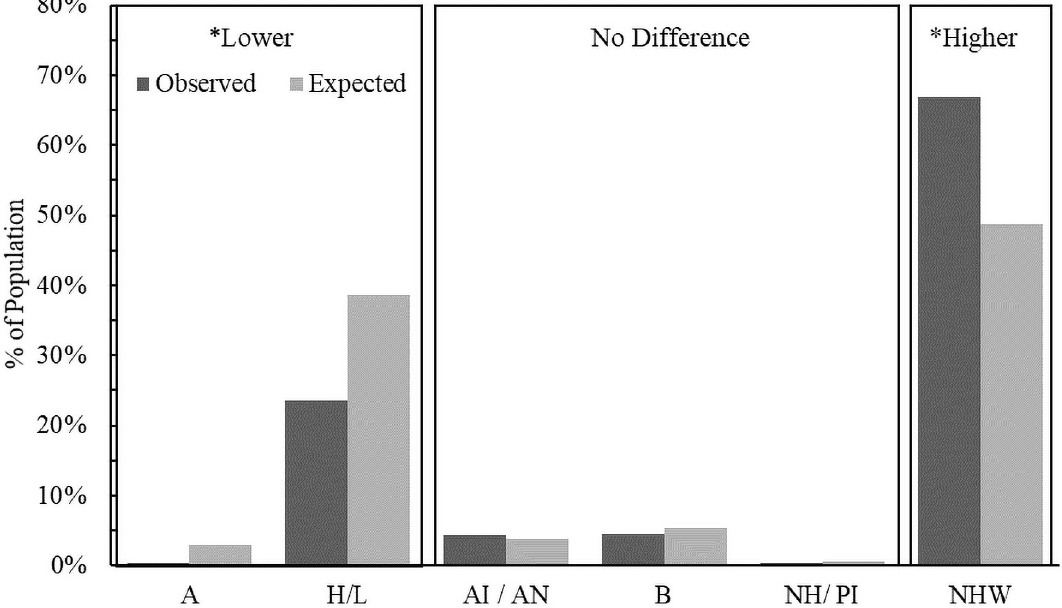
Fig 2. Comparison of the observed versus expected proportions of NOWS in each racial/ethnic group of infants. Boxes labelled higher or lower indicate that observed proportions are significantly higher or lower than expected proportions based on a chi-square analysis after post-hoc comparisons that incorporate a Bonferroni correction with six groups (p < 0.001/6). A: Asian, H/L: Hispanic or Latino, AI/AN: American Indian or Alaskan Native, B: Black, NH/PI: Native Hawaiian or Pacific Islander, NHW: Non-Hispanic